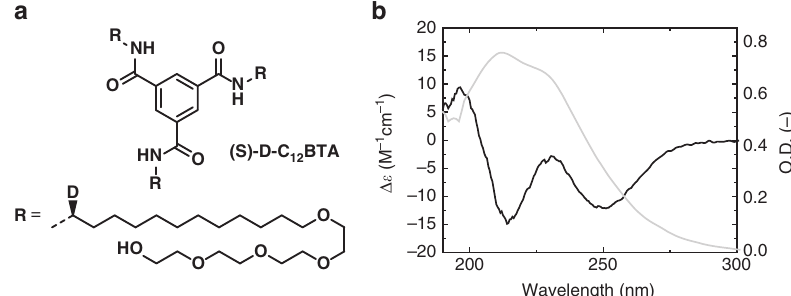
Figure 6 | Chiral BTA assembly. ( a ) Chemical structure of stereoselectively deuterated ( S )-D-C 12 BTA and, ( b ) circular dichroism (black line) and UV- absorption spectrum (grey line) in water after equilibration for 4 weeks ( c ¼ 50 m M, T ¼ 20 (cid:2) C, path length ¼